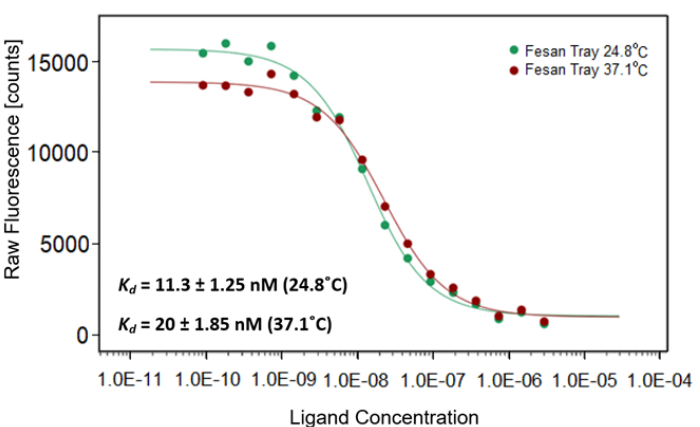
Figure 9. Curves obtained from microscale thermophoresis experiments aimed assessing the strength of the interactions between ferra(III) bis(dicarbollide) and the venom proteins fluorescently labeled with RED-NHS 2nd generation. The protein samples were titrated with ferra(III) bis(dicarbollide) at concentrations ranging from 182 pM to 3000 nM. The experiments were run at 24.8 °C and 37.1 °C. The ligand concentration is given in M.